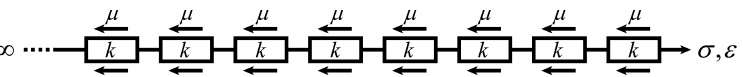
Figure 2. Straight chain of molecules abstracted from microfibers.